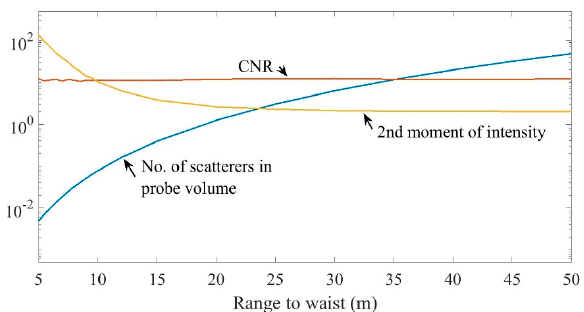
Figure 7. Results from one simulation of a lidar with uniform aerosol seeding density, fixed aperture, and varying focus range. Average CNR is almost independent of focus range, despite the variation of 4 orders of magnitude in probe volume. Normalised 2nd moment of intensity <I 2 >/<I> 2 is large at short ranges but closely approaches 2 (characteristic of complex Gaussian statistics) if there are “many” randomly arranged scatterers (say a few tens or more) in the probe volume. Figure 1.4 in Banakh and Smalikho [9] is similar, illustrating their analytical expressions for “echo power” and the number of efficiently scattering particles, with specific model assumptions for a CO (cid:2870) atmospheric lidar ( λ = 10.6 μ m). Here, the simulation assumes constant measurement time (120 ms) at each focus range. At the shortest ranges, there are so few scatterers contributing that the results for CNR and 2nd moment are noisy. (The “No. of scatterers in probe volume” plotted is a theoretical average number given by (2 λ 3 / π 2 ) × (focus distance/beam waist radius) 4 × (seeding density), so it is not noisy). As the range increases to tens of metres, the number of scatterers contributing rises quickly, because of this fourth-power dependence of probe volume on range [24]. The CNR is almost constant with range as we expect, and the 2nd moment of intensity falls to very nearly 2 when the probe volume contains tens of scatterers. This computer run uses λ ~ 1.57 μ m and w (cid:2868) ~ 15 mm, with a seeding density of 500,000 m − 3 , and with the scatterer reflectance and shot noise level set to give a CNR of about 10 in a bandwidth of 10 MHz. The 2nd moment is more than 100 at the shortest range of 5 m but within 1% of 2.00 for ranges above 45 m. Of course, more stable results at the shorter ranges can be obtained if (for example) we simulate a different experiment where the total number of contributing scatterers (rather than the measurement time) is fixed at each range. Such a simulation is easily run for hundreds or thousands of scatterers on a PC. This was harder 40 years ago, for example when Mayo [29] modelled the “triply stochastic” physics of turbulent flow, particle arrivals, and photodetections. Two more papers emphasising the practical side rather than simulations, but relevant to understanding the various models, are the following: